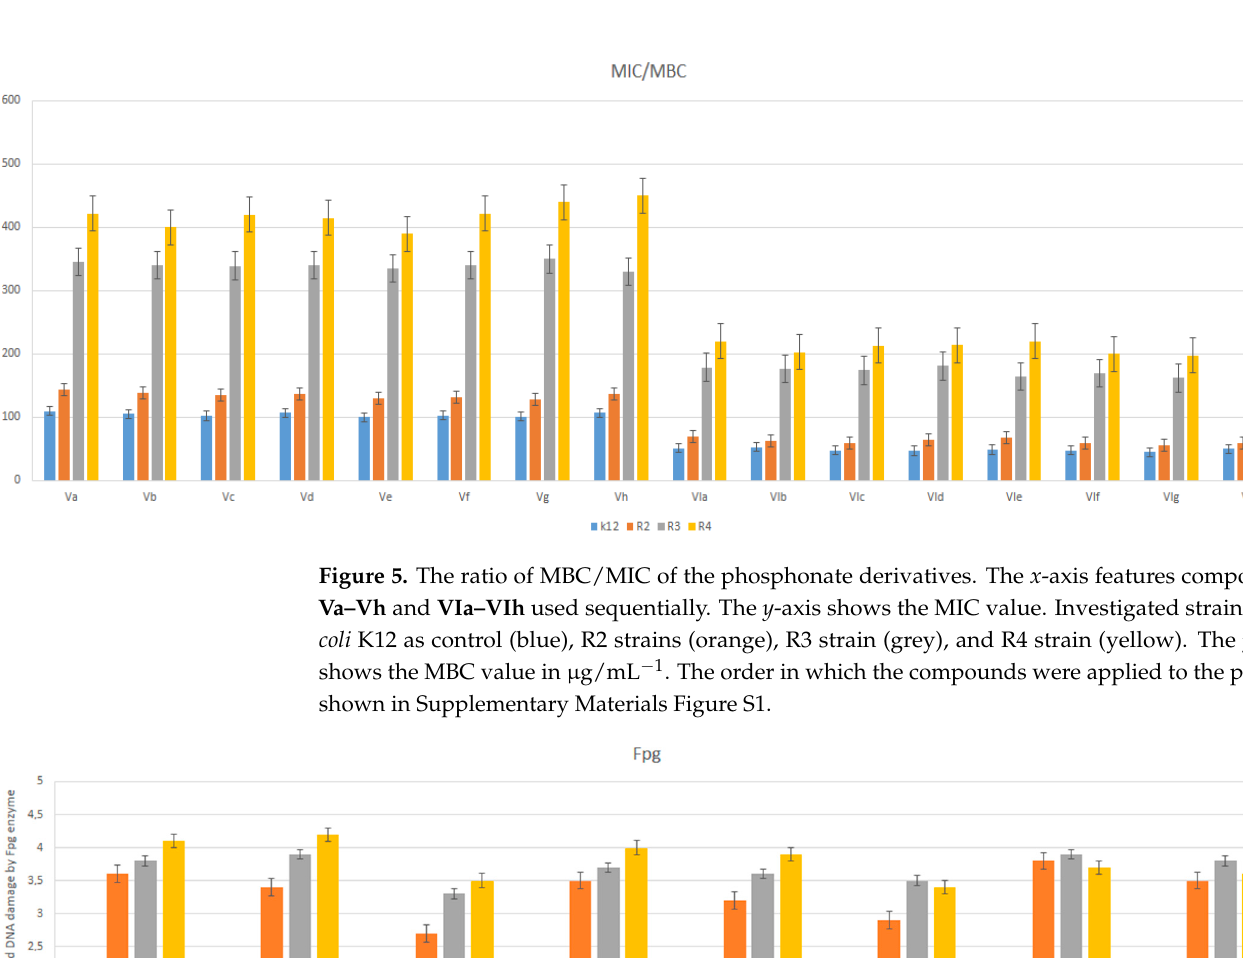
Figure 4. Minimum bactericidal concentration (MBC) of the phosphonate derivatives. The x -axis features compounds Va–Vh and VIa–VIh used sequentially. The y -axis shows the MIC value in μ g/mL − 1 . Investigated strains of E. coli K12 as control (blue), R2 strains (orange), R3 strain (grey), and R4 strain (yellow). The y -axis shows the MBC value in μ g/mL − 1 . The order in which the compounds were applied to the plate is shown in Supplementary Materials Figure S1.